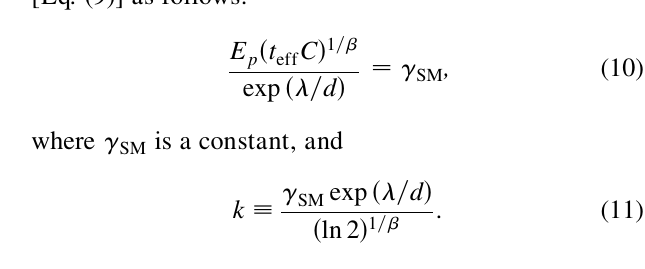
mately proportional to exp (cid:3) (cid:9)=d (cid:4) , where (cid:9) is a constant,